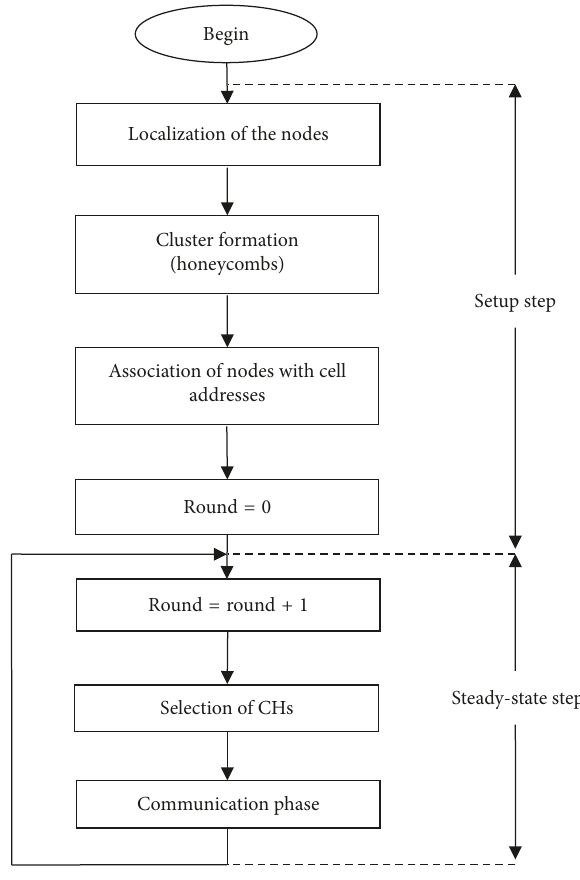
Figure 1: Flowchart of the protocol